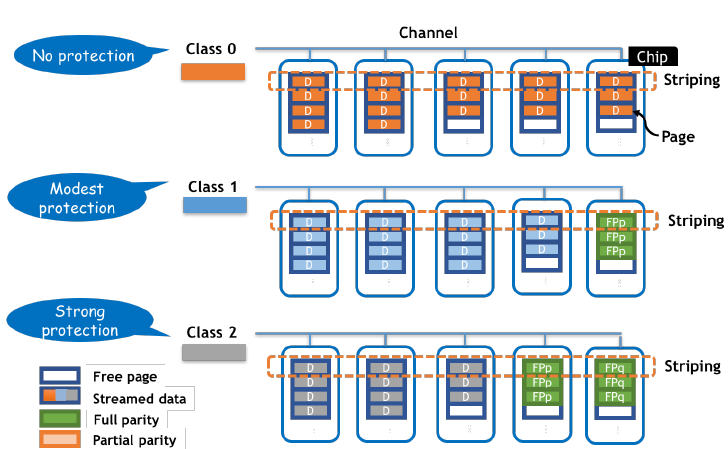
Figure 2. Overall architecture of mSAPL .